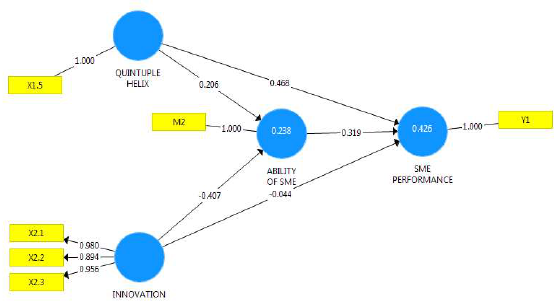
Fig. 5. Fit model Indonesia craft sub sector